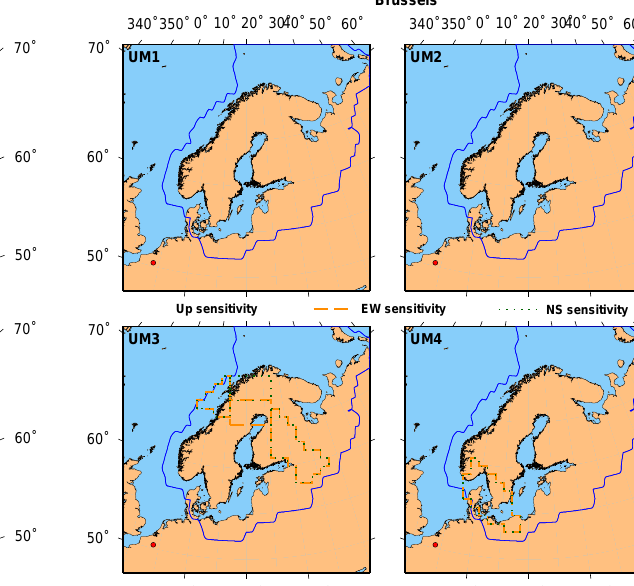
and Brussels show no sensitivity to any block in this layer, while Riga has sensitivity (for all components) to block num- ber 7 in the second layer (Fig. 2).